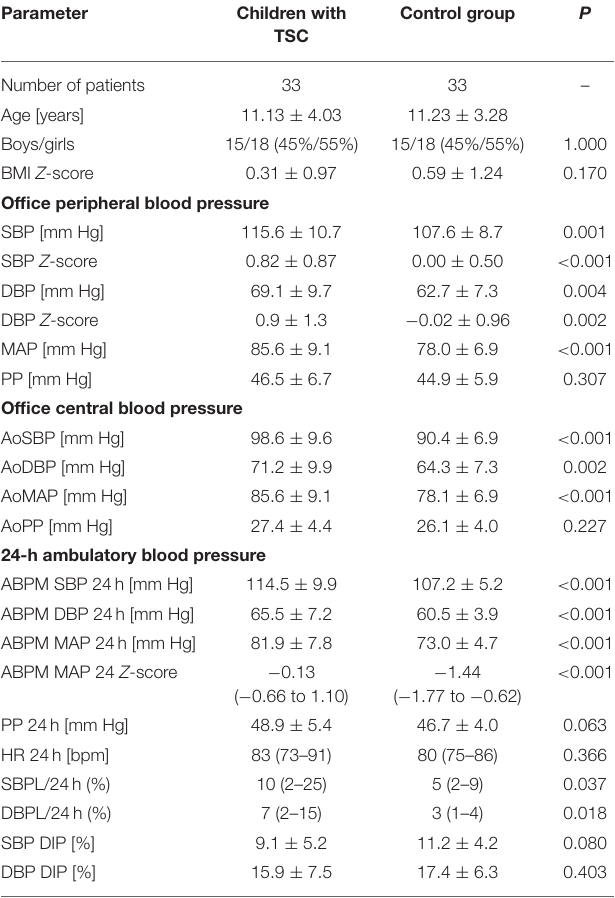
TABLE 2 | Blood pressure in children with TSC and in healthy